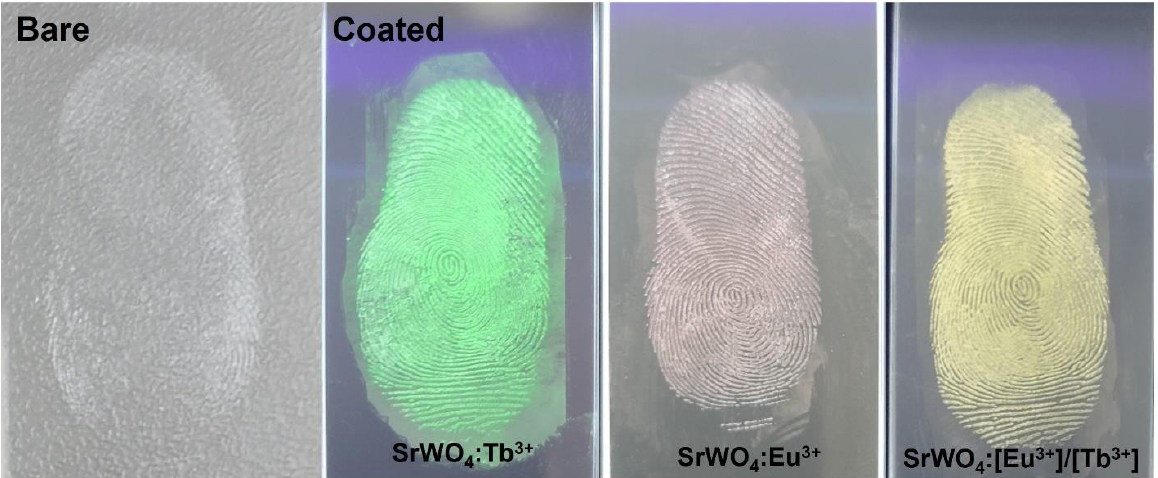
Figure 9. Images of fingerprint coated with phosphors under a UV lamp.